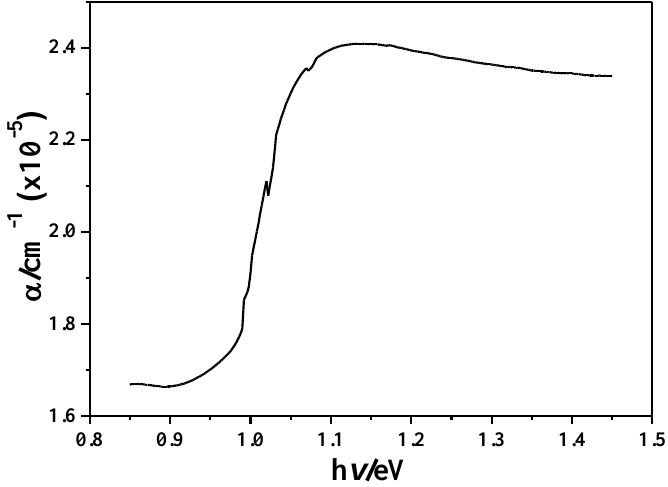
Figure 8. Photon energy dependences of the absorption coefficient for annealed CIS absorber